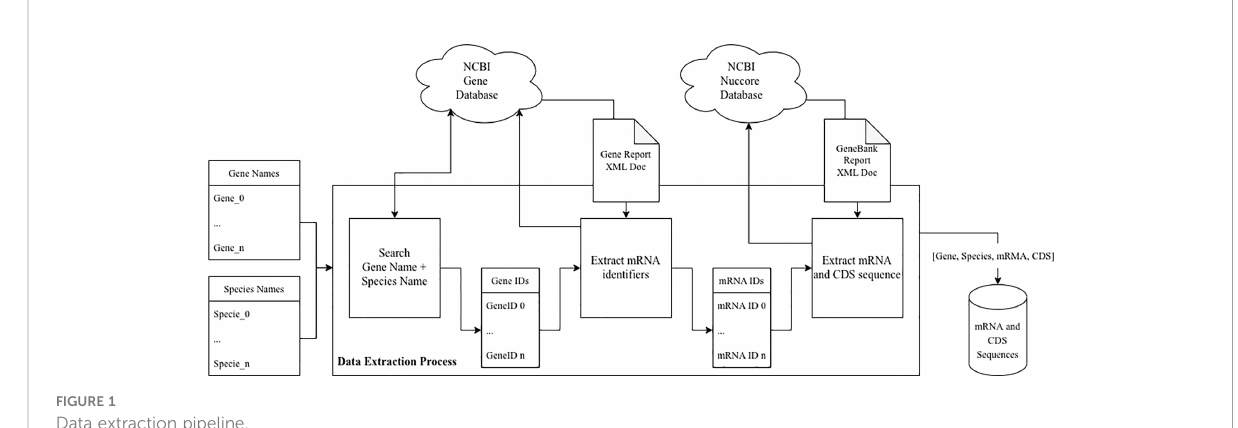
FIGURE 1 Data extraction